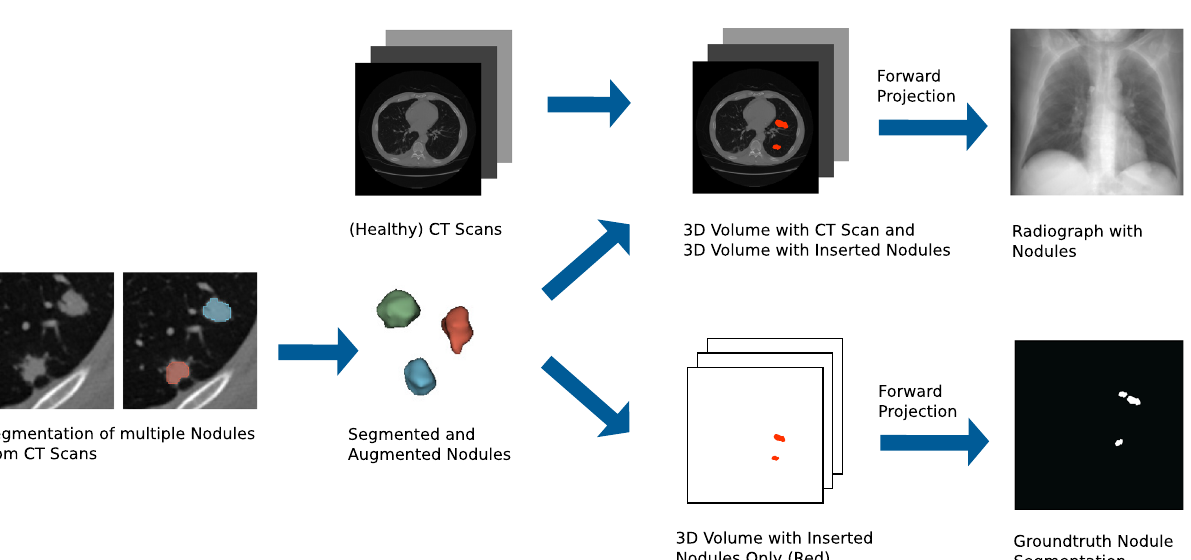
Figure 5. Workflow for generating synthetic radiographs containing tumour nodules with perfect ground truth knowledge. Based on natural shapes, various sizes of tumors are generated and subsequently inserted into clean CT scans and different locations. The 3D CT data set is then forward projected to generate p.a. thorax radiographs. In parallel, the tumors only are forward projected to obtain perfect ground-truth masks. These ground-truth masks is later used to compare the radiologist’s findings with the expected